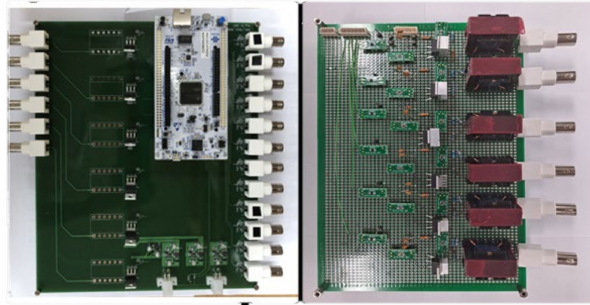
Figure 11. The control circuit of a plane array of smart skin absorbers.